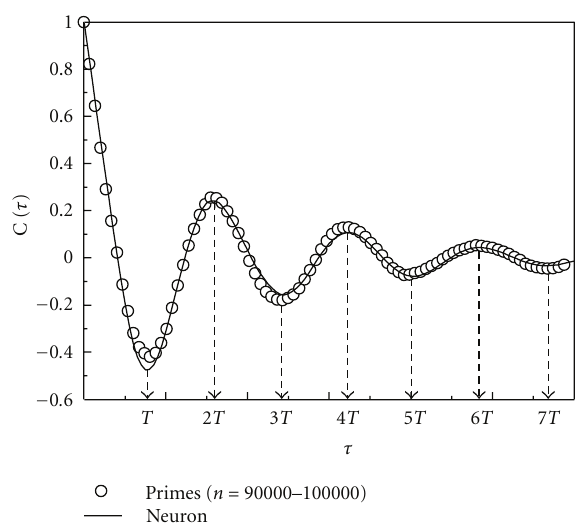
Figure 7: Autocorrelation of the v (cid:2) n (cid:3) functions for the ln-sequence (cid:2) circles (cid:3) in the interval 9 × 10 4 < n < 10 5 . The solid curve corresponds to autocorrelation function computed for the telegraph signals corresponding to a spontaneous activity of a hippocampal (cid:2) CA3 (cid:3) singular neuron (cid:2) cf. Figure 3 (cid:3) . In order to make the autocorrelation functions comparable a rescaling has been made for autocorrelation of the v (cid:2) n (cid:3)